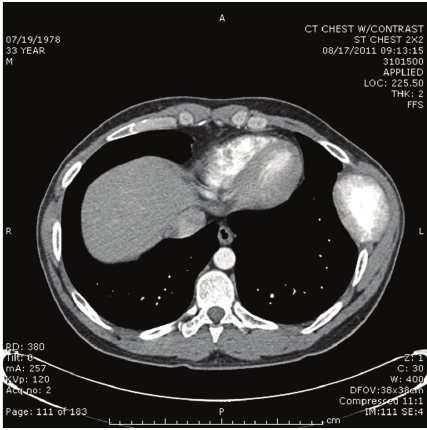
Figure 1: CT scan of the chest showing a large mass of the left lateral aspect of the seventh rib with bony matrix and sunburst central core.